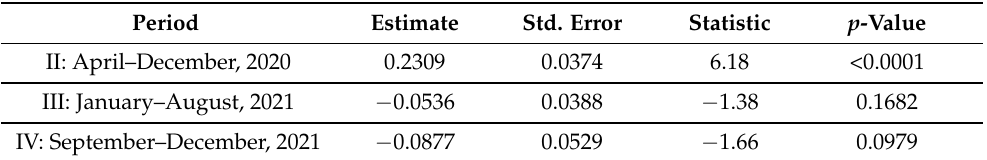
Table 4. Panel data analysis. Estimates of parameters (Period I, January 2017–March 2020, was used as the reference